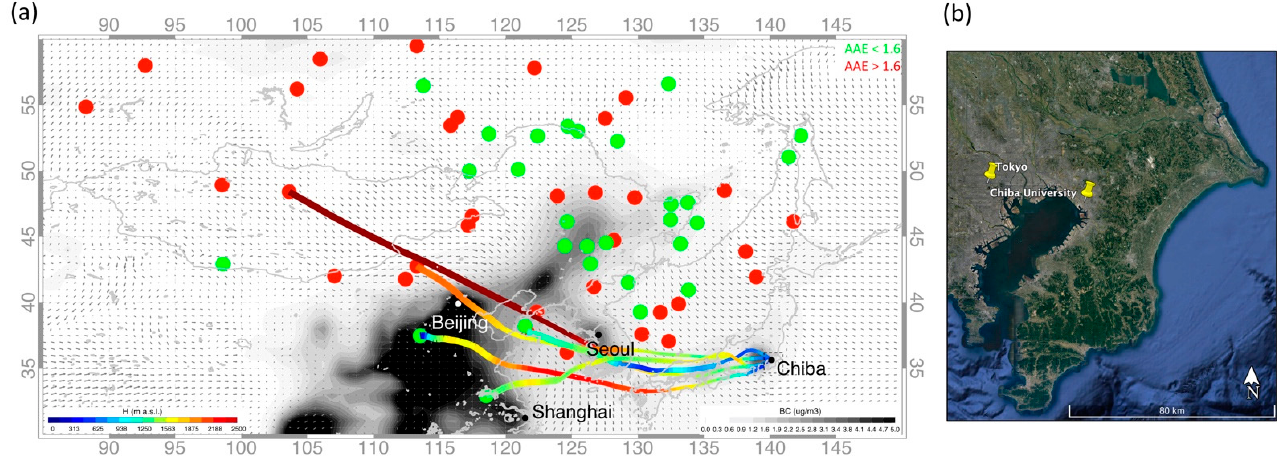
Figure 1. ( a ) The 72-h backward trajectories for days with large surface BC concentrations at Chiba overlain on a map of the distribution of the mean surface BC (gray scale) concentration and wind speed/direction at 10 m a.s.l., as estimated by MERRA-2 for November 2019 to December 2020. The arrival height and arrival time at Chiba University station ( b ) were set at 500 m a.s.l. and at 0300 UTC (1200 JST), respectively. Colors show the boundary layer height. The increasing thick line of the trajectories highlights the 0–24 h, 25–48 h, and 49–72 h periods. The green and red circles show the geographic origin of the 72-h backward trajectories for days characterized by AAEs of <1.6 and >1.6, respectively, as estimated by sky radiometer observations. Only days with an AE > 1 and low RH are shown.